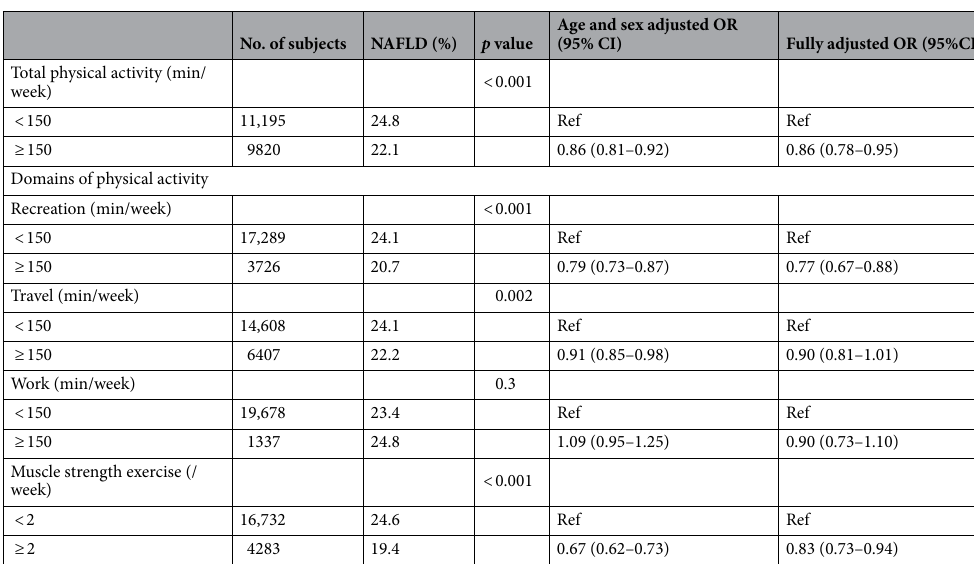
Table 2. Risk of non-alcoholic fatty liver disease according to the level of physical activity and muscle strength exercise. Fully adjusted model was adjusted for age (continuous), sex, body mass index (continuous), elevated waist circumference (yes vs. no), elevated triglycerides (yes vs. no), reduced high-density lipoprotein cholesterol (yes vs. no), diabetes mellitus (yes vs. no), hypertension (yes vs. no), income levels (Q1, Q2, Q3, and Q4), education (elementary or lower, middle school, high school, college or higher), smoking (current, ex-smoker, and never smoker), alcohol consumption (< 10 g/day vs. ≥ 10 g/day), total physical activity (< 150 min/week vs. ≥ 150 min/week), and muscle strength exercise (< 2/week vs. ≥ 2/week). For specific domains of physical activity, other domains were adjusted as follows: Recreation: travel and work activity (< 150 min/ week vs. ≥ 150 min/week), Travel: recreation and work activity (< 150 min/week vs. ≥ 150 min/week), Work: recreation and travel activity (< 150 min/week vs. ≥ 150 min/week). NAFLD non-alcoholic fatty liver disease, OR odds ratio, CI confidence interval.